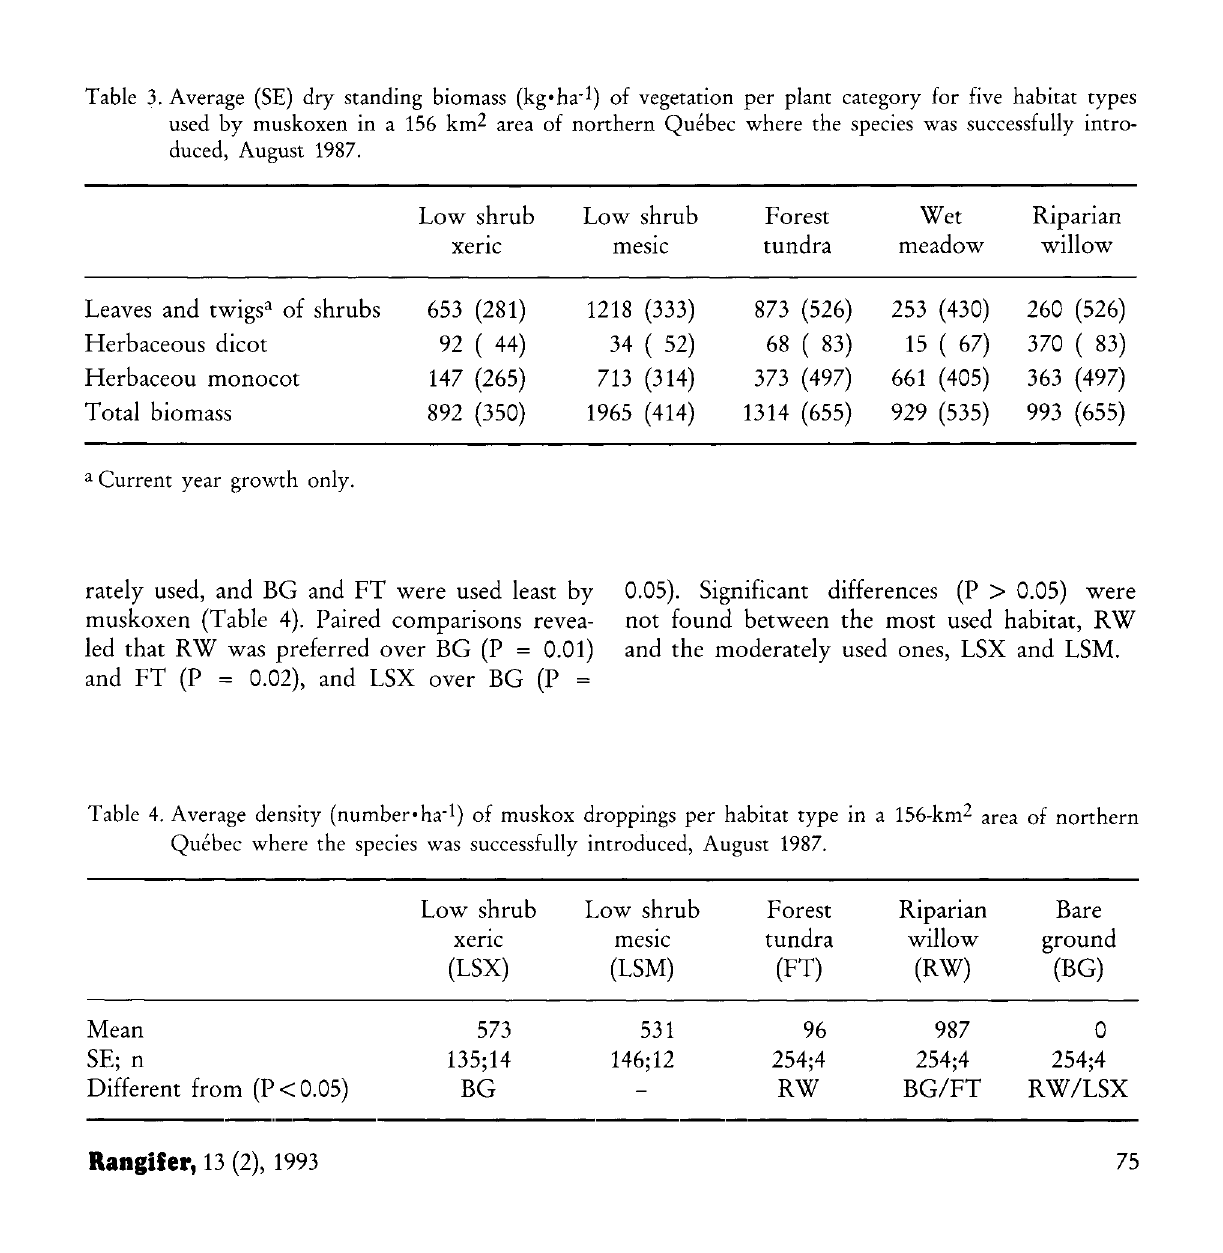
Table 3. Average (SE) dry standing biomass (kg•ha -1 ) of vegetation per plant category for five habitat types used by muskoxen in a 156 km 2 area of northern Quebec where the species was successfully intro duced, August 1987.